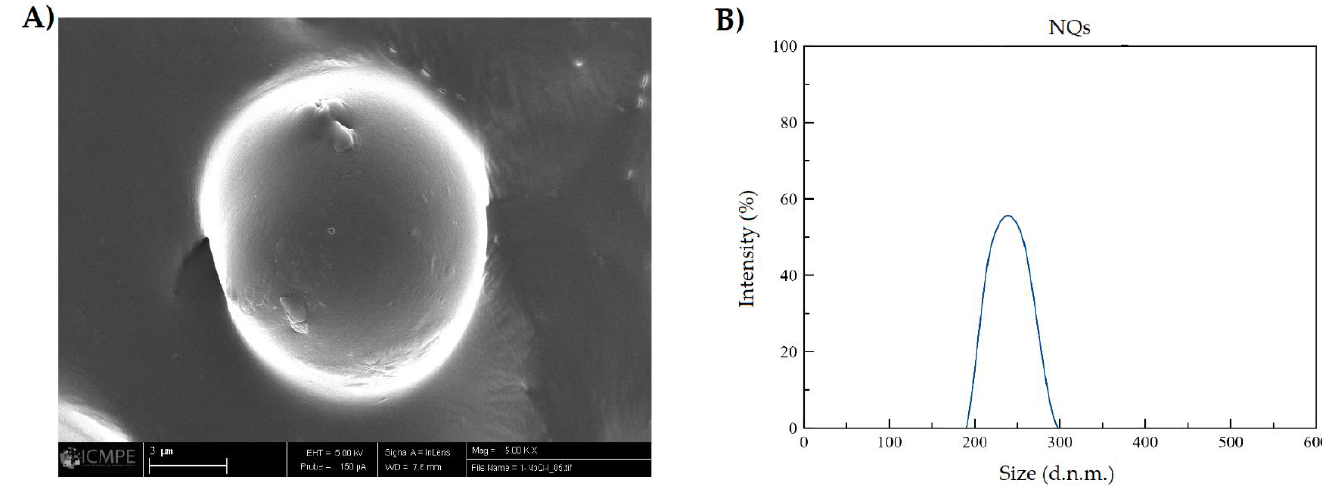
Figure 5. Size characterization of nanoparticles loaded with quercetin. ( A ) SEM image of inulin nanoparticles loaded with quercetin (NQs) (5000× magnification, scale 3 µm). ( B ) DLS NQs reconstituted in organic solvent (absolute ethanol).